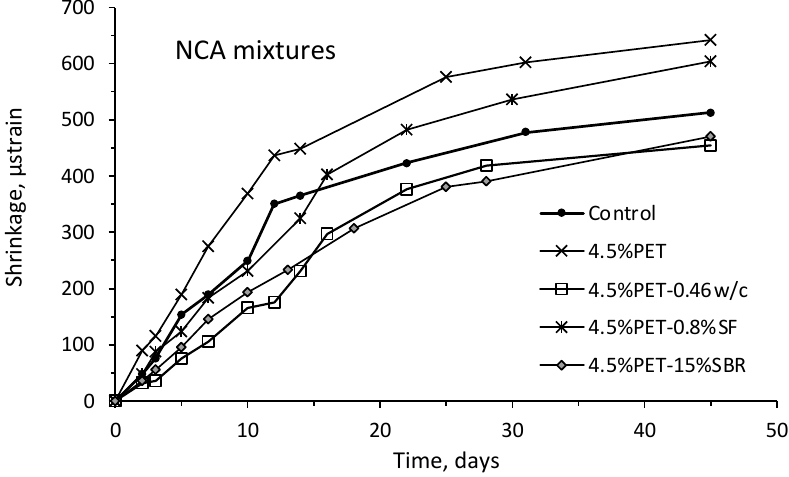
Figure 6. Variations of drying shrinkage over time for control and 4.5% PET-modified concrete.